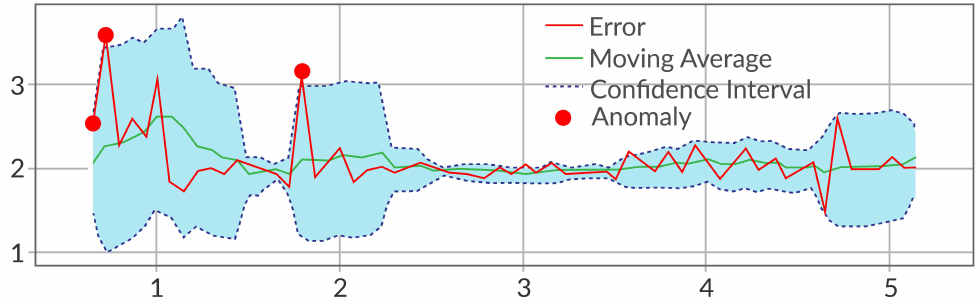
Figure 3. Determination of confirmed outliers and anomalies for time series data